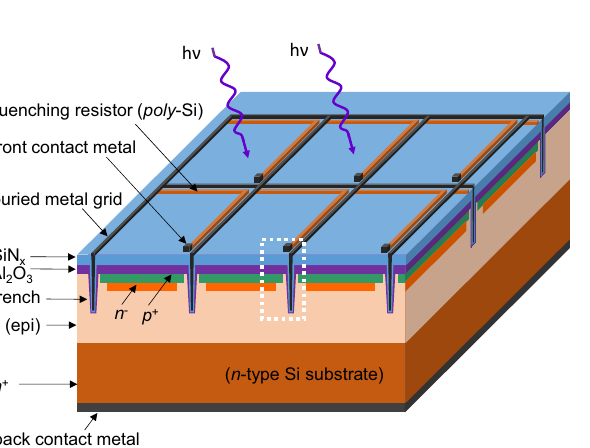
Figure 9. Comparison summary of the average reflections of bare Si (no ARC), single-layer, double-layer, and triple-layer ARC on planar and textured surfaces. The error bars are included.